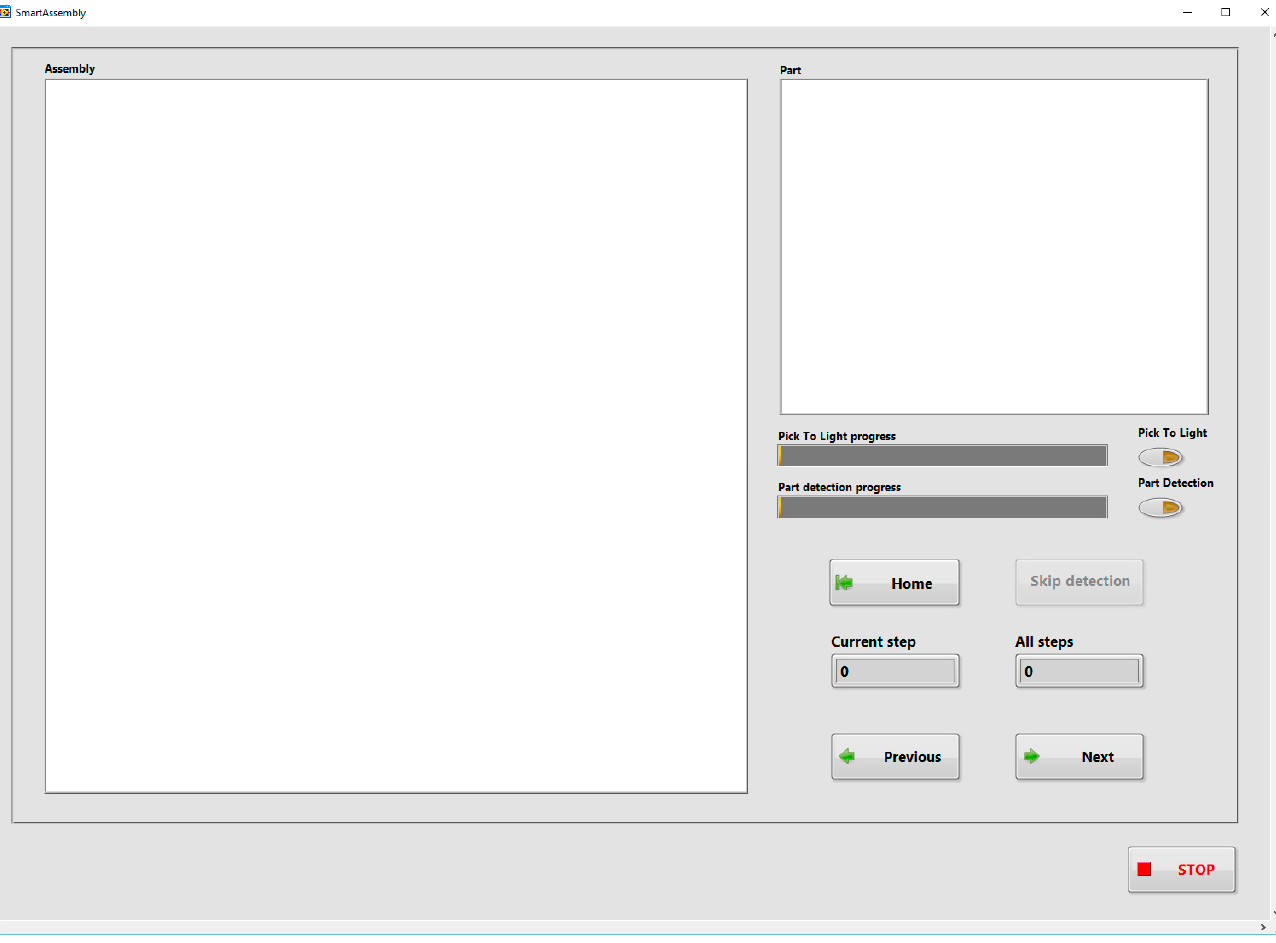
Figure 5. Main application GUI.